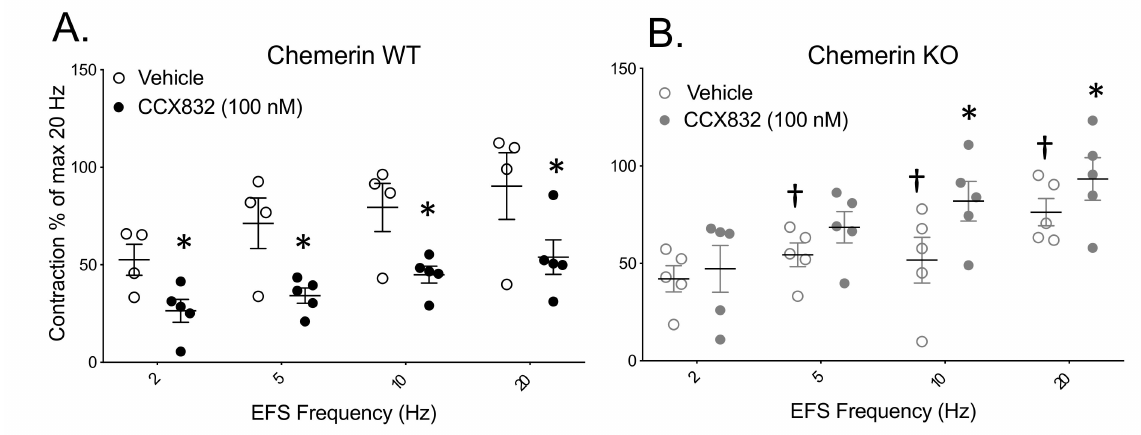
Figure 2. Endogenous activation of Chemerin1 by chemerin amplifies EFS-induced contraction in WT but not KO tissues. The Chemerin1 antagonist CCX832 alone reduced EFS-induced contraction in the superior mesenteric arteries from WT ( A ) but not KO rats ( B ). Horizontal bars represent means ± SEM for number of points scattered around mean. A two-way ANOVA with a Bonferroni correction was used to determine statistical di ff erences in EFS maximums. * = statistical di ff erence from paired vehicle response; † from frequency paired WT